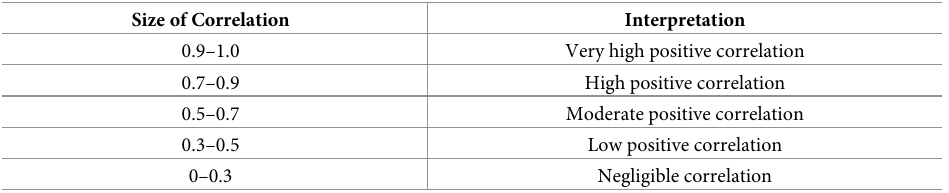
Table 1. Interpreting the size of a correlation